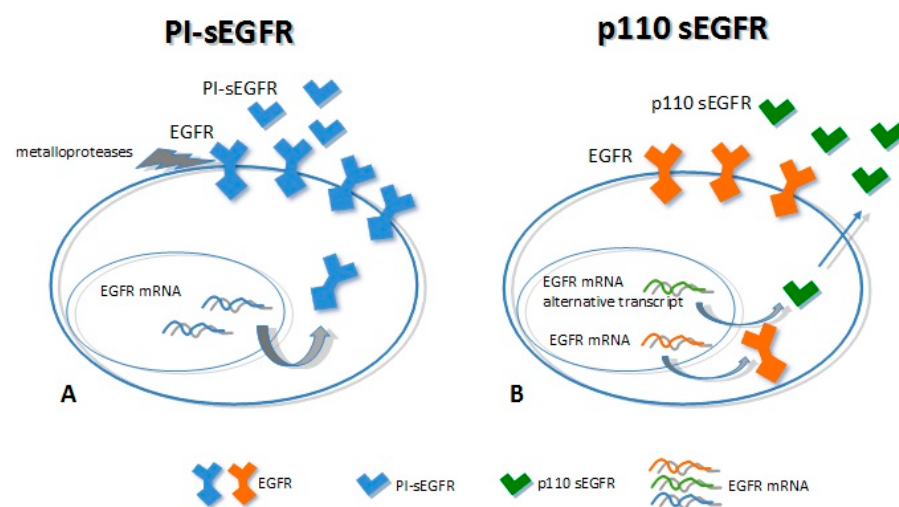
Figure 2. Mechanisms of soluble epidermal growth factor receptor (sEGFR) generation. ( A ) The full-length EGFR is cleaved by metallo-proteases (receptor shedding) to release the extracellular domain (PI-sEGFR); ( B ) Alternative splicing of the mRNA coding for the EGFR originates an alternative transcript that encodes (curved gray arrows) for the sEGFR p110 isoform, which is secreted in the extracellular environment (blue arrow).